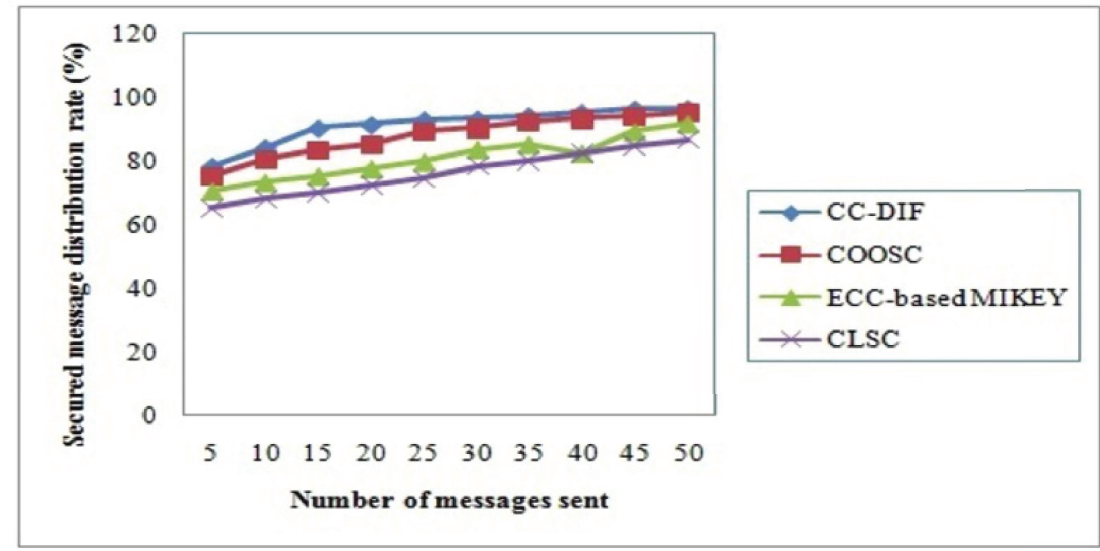
Fig 6. Secured messagedistribution rate of CC-DIF and three existing